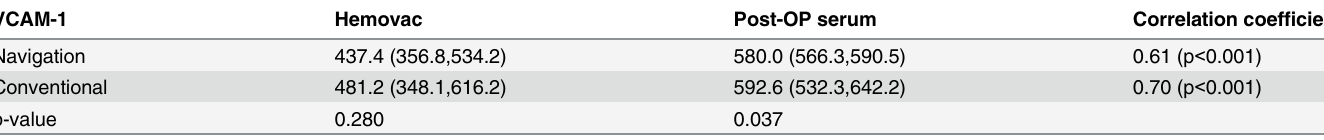
Table 6. Correlation of VCAM-1 concentrations (unit: ng/mL) in hemovac samples and postoperative serum samples.